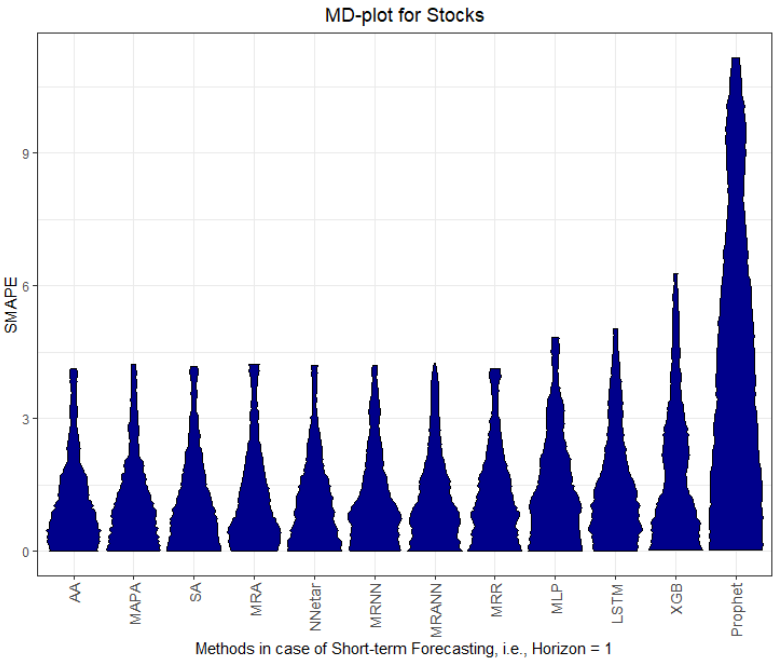
Figure A5. Mirrored density plot of Symmetric Mean Absolute Percentage Errors (SMAPE) computed with a rolling forecasting origin for horizon 1 on dataset